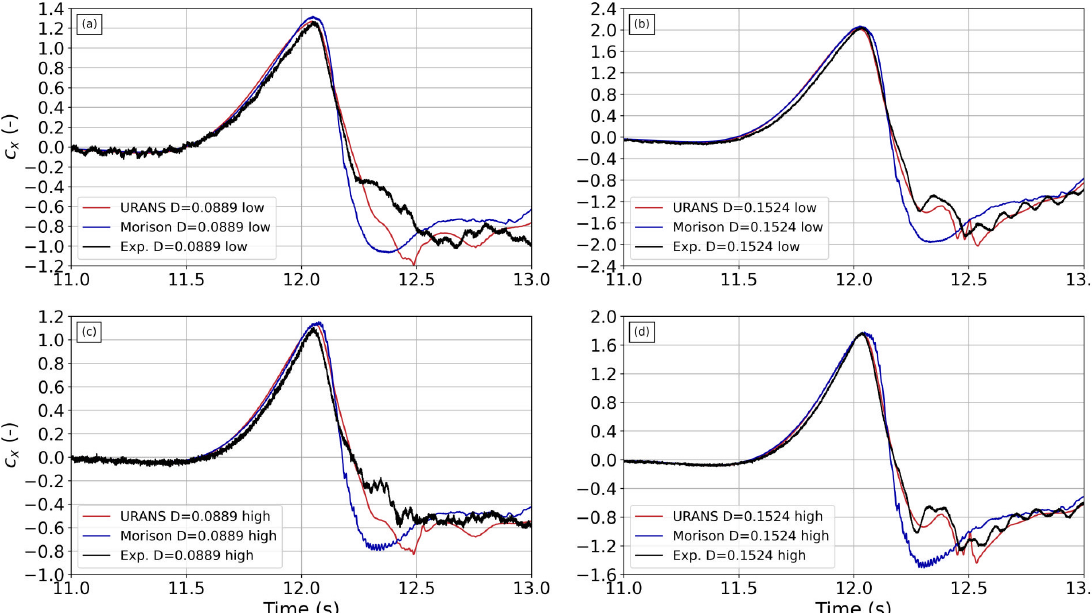
Figure 14. Time histories of load coefficient c x in scenario 1 for the small ‐ diameter cylinder in its low position ( a ), for the large ‐ diameter cylinder in its low position ( b ), for the small ‐ diameter cylinder in its high position ( c ), and for the large ‐ diameter cylinder in its high position ( d